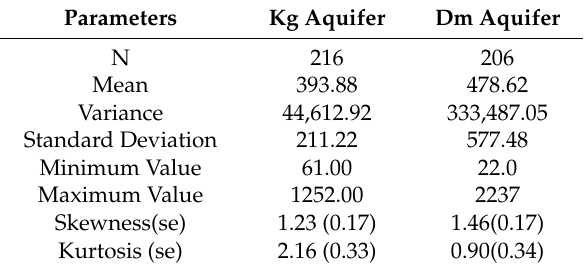
Table 1. Summary statistics for the transmissivity of the Dm and Kg aquifers in Kuwait.